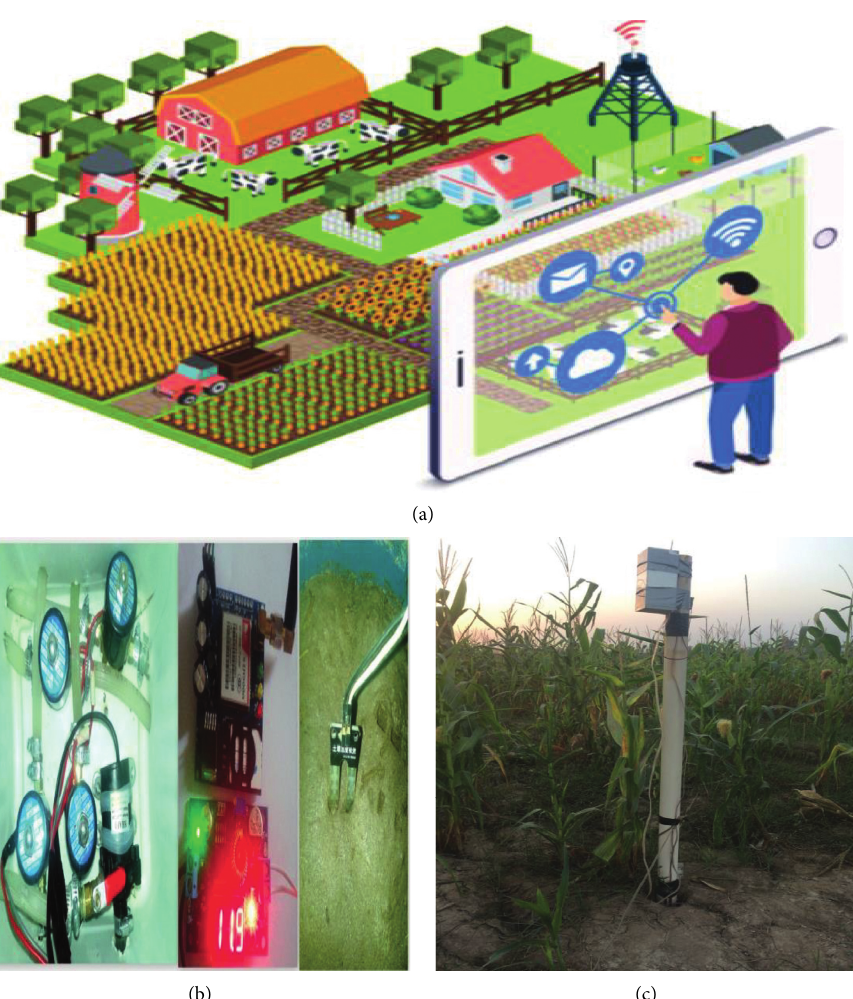
Figure 5: On-site test for automated irrigation: (a) layout sketch; (b) solenoid valves, GSM module, and moisture sensor; (c) installed moisture